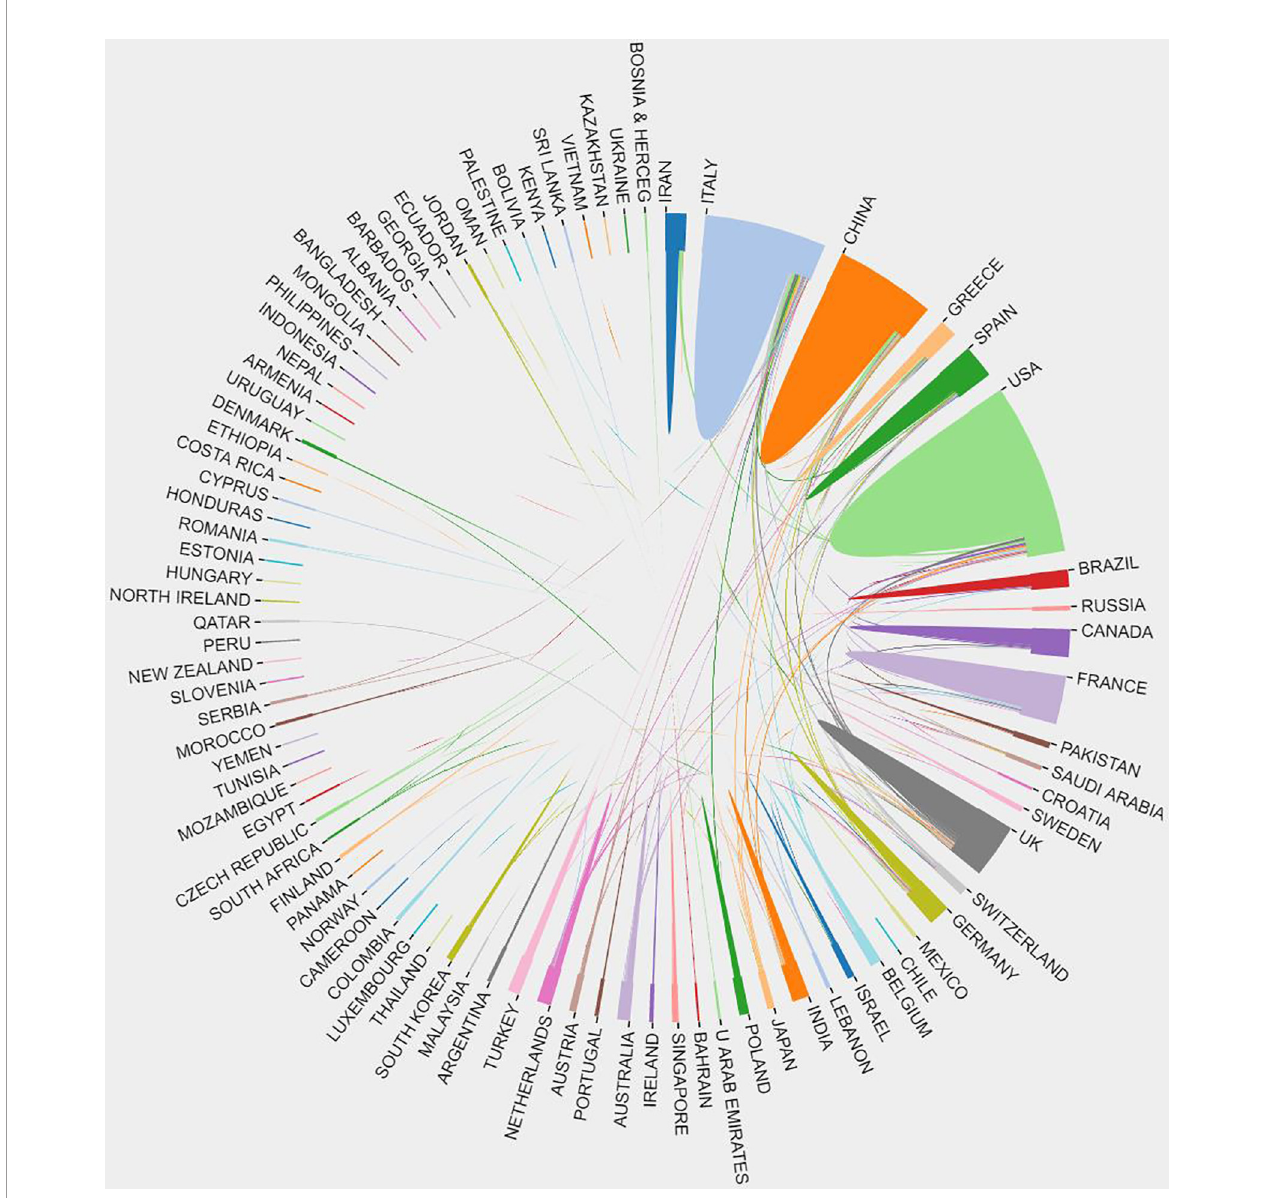
FIGURE 2 | The distribution of countries/regions. The cooperation of